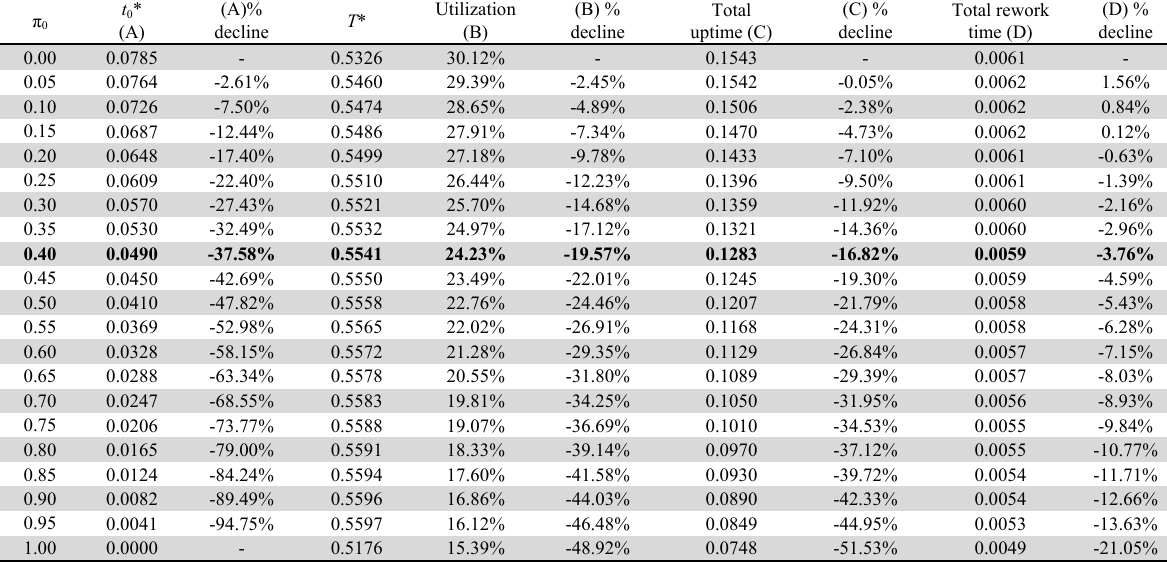
Impact of changes in π 0 on utilization & diverse system fabrication-related variables